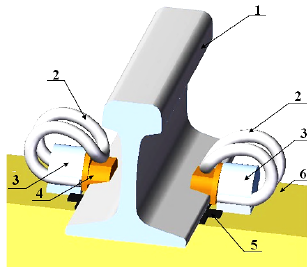
Fig. 1. Construction of KПП-5 fastener: 1 – rail; 2 – elastic terminal; 3 – anchor; 4 – polymeric bearing; 5 – laying; 6 – crosstie In Ukraine about 5